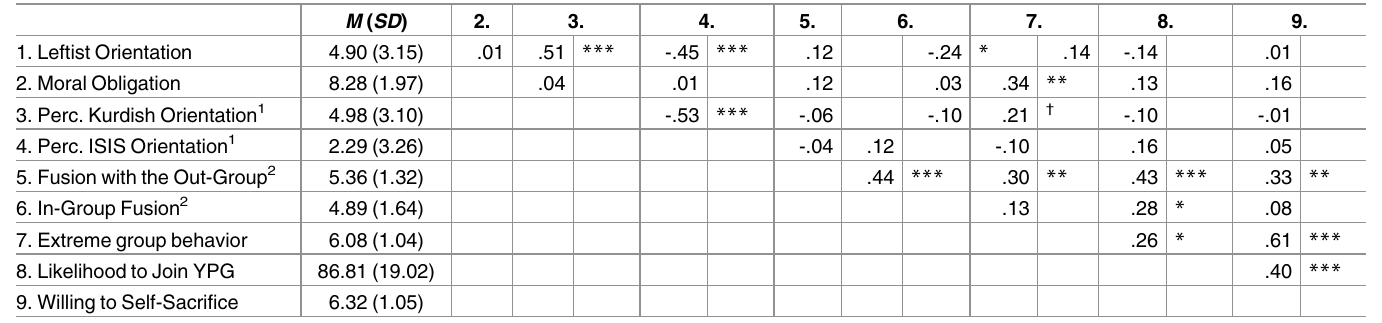
Table 6. Means, Standard Deviations and Correlations between variables in Study 4 are displayed.